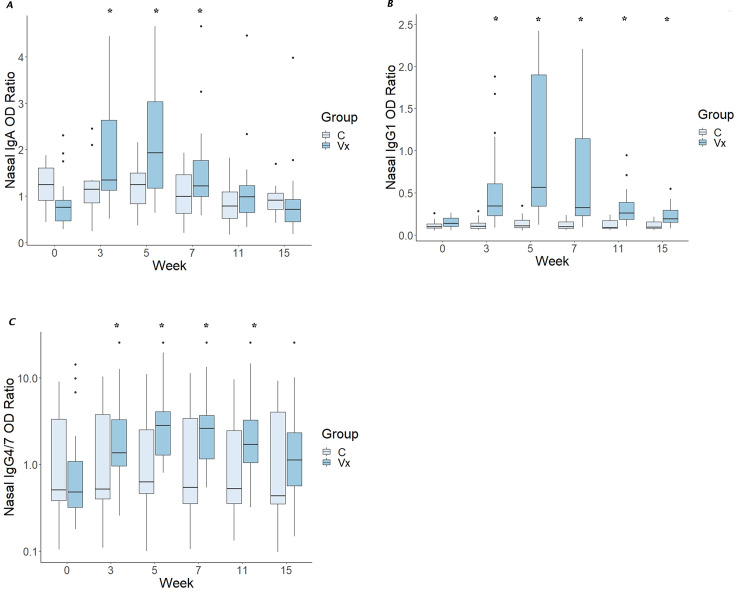
Vaccination significantly increased nasal titers of IgA, IgG1, and IgG4/7.Boxplot of ratios of optical density of antibodies in nasal samples relative to a positive control of IgA (panel A), IgG1 (panel B; next page), and IgG4/7 (panel C) among vaccinates (Group = Vx; n = 20) and controls (Group = C; n = 10). The bottoms and tops of the boxes represent the 25th and 75th percentiles, and the horizontal lines in the boxes represent the medians; the thin vertical lines extend to a multiple of 1.75 of the respective interquartile distance, and the small circles represent outliers. Asterisks indicate significant (P < 0.05) difference from baseline (Week 0) among vaccinates. For controls, there were no significant differences in concentrations among times. For IgA (A), IgG1 (B), and IgG4/7 (C), concentrations were significantly (P < 0.05) higher than baseline through week 7, 11, and 15, respectively.